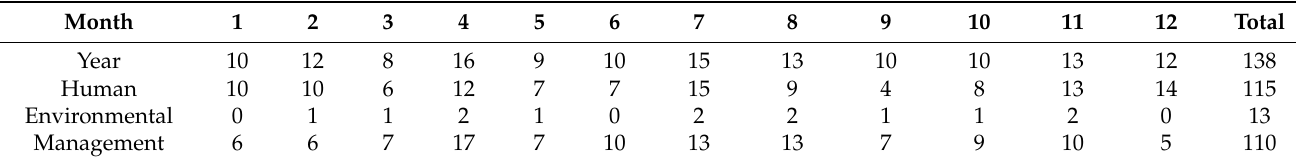
Table 5. Frequency for causes of large and above accidents each